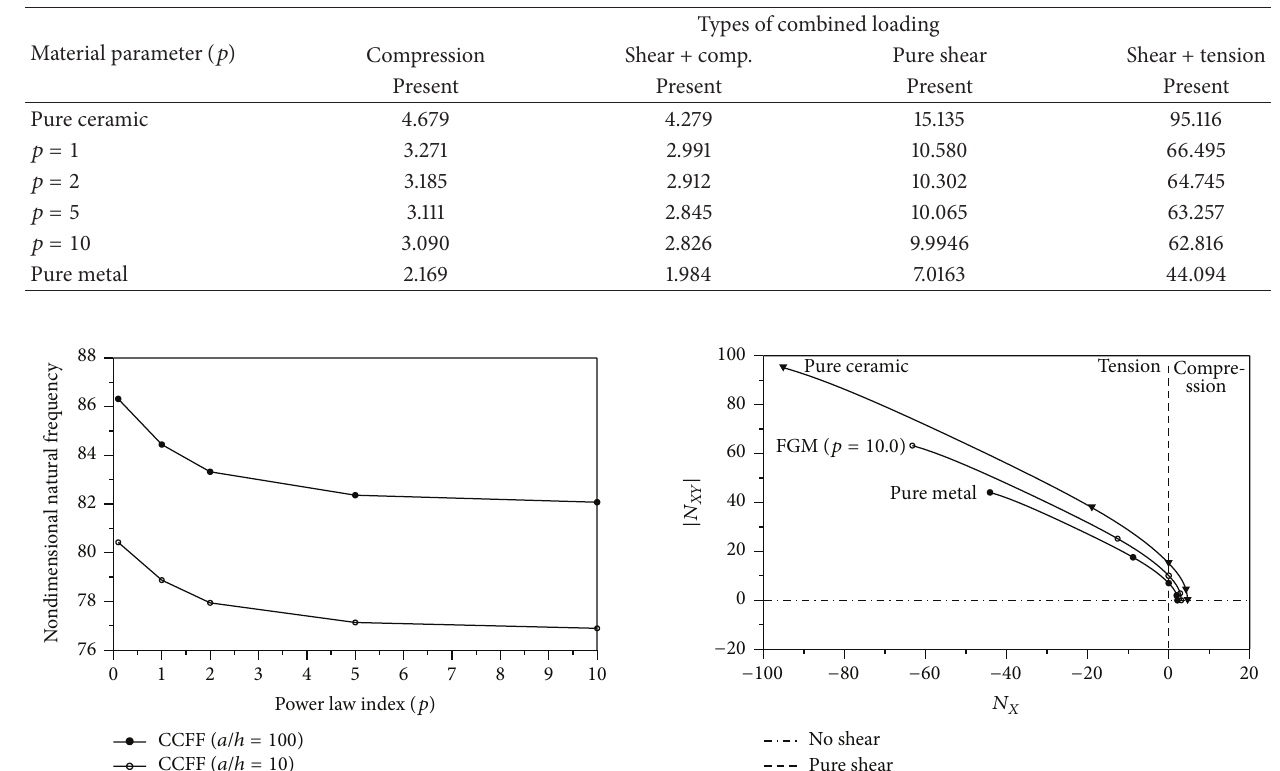
= (𝑁 𝑏 2 /𝐸 ℎ 3 ) × 10) . 2 cr cr